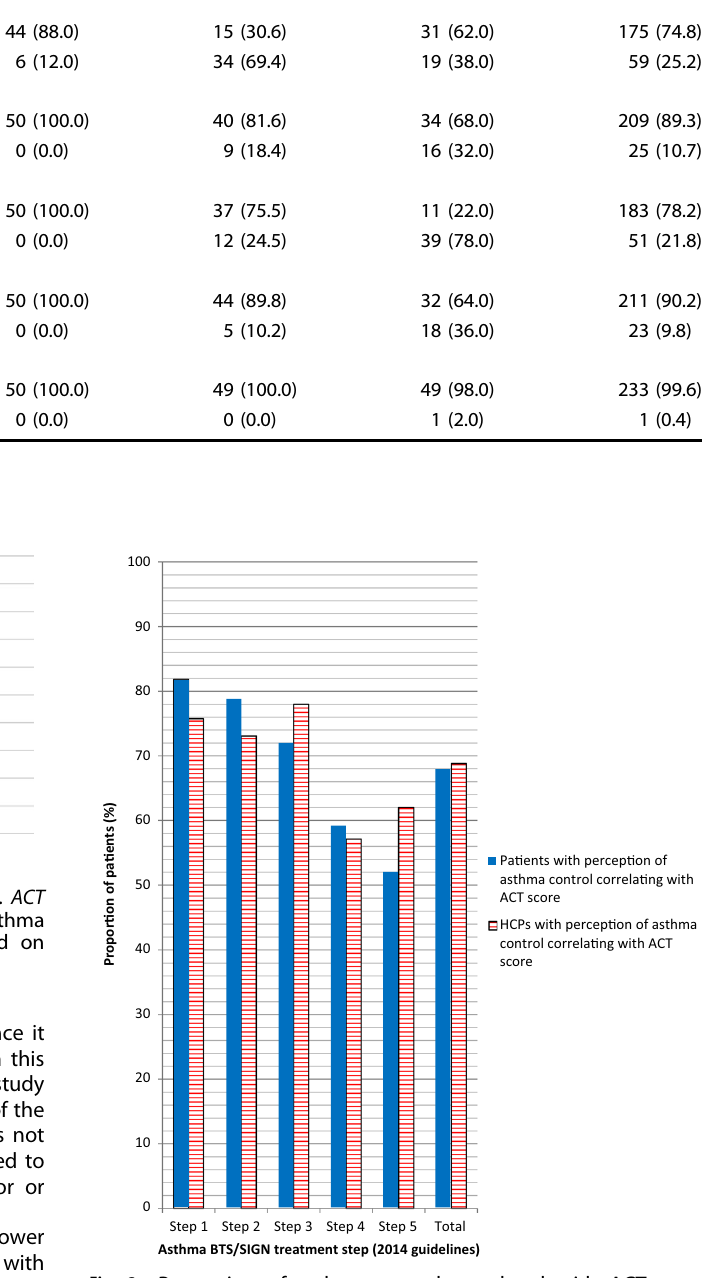
Fig. 2 Perception of asthma control correlated with ACT score: patient vs. HCPs ( n = 234). ACT asthma control test, BTS/SIGN British Thoracic Society/Scottish Intercollegiate Guidelines Network, HCP healthcare professional. Percentages are based on the number of patients in the full analysis set. BTS step 1 = Mild intermittent asthma, step 2 = Regular preventer therapy, step 3 = Initial add-on therapy, step 4 = Persistent poor control, step 5 = continuous or frequent use of oral steroids (2014